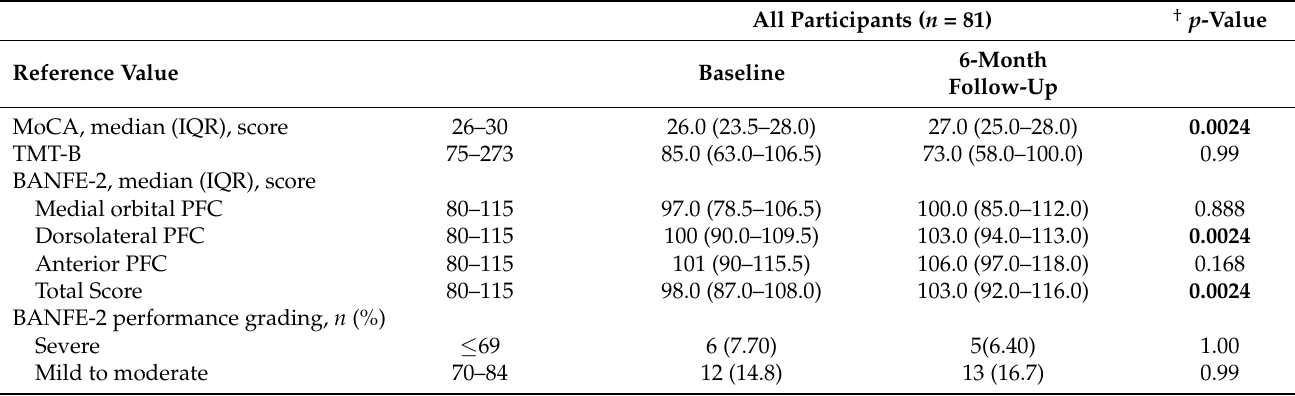
Table 3. Comparison of cognitive performance at baseline and after six months in a multidisciplinary weight loss